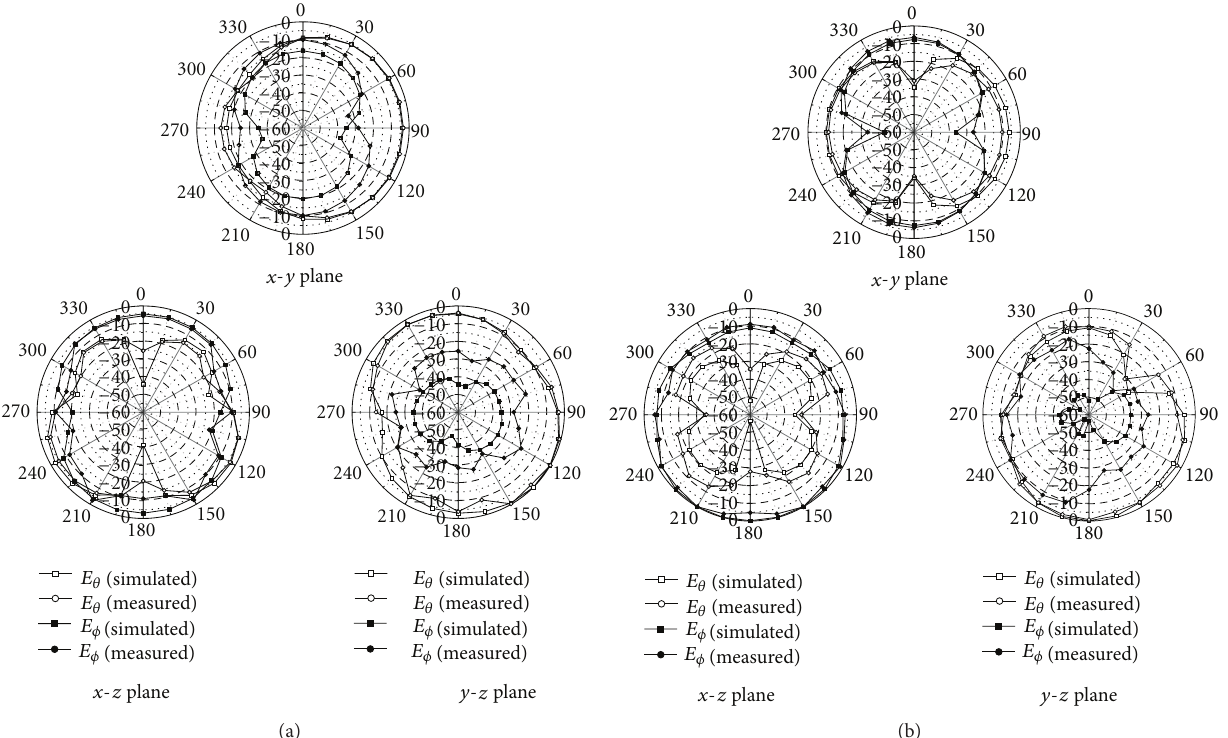
F 10: Simulated and measured 2D radiation patterns of proposed antenna: